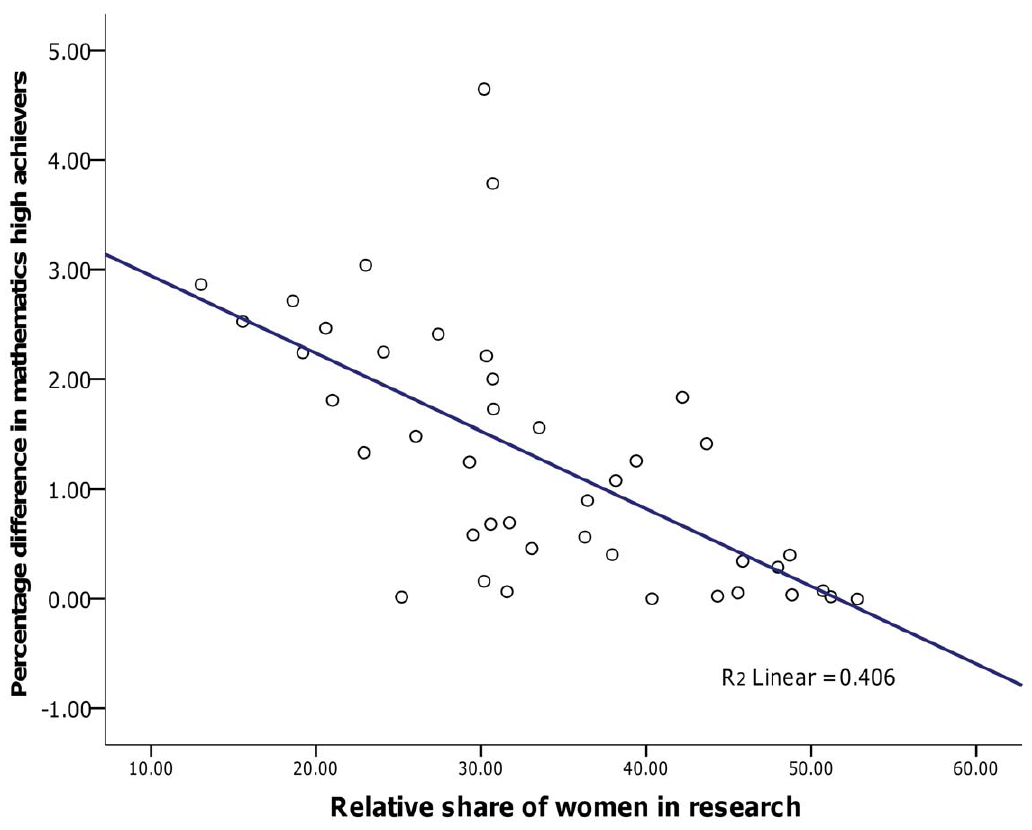
Figure 3. Relationship between women in research and gender ratios of high-achievers in mathematics literacy.